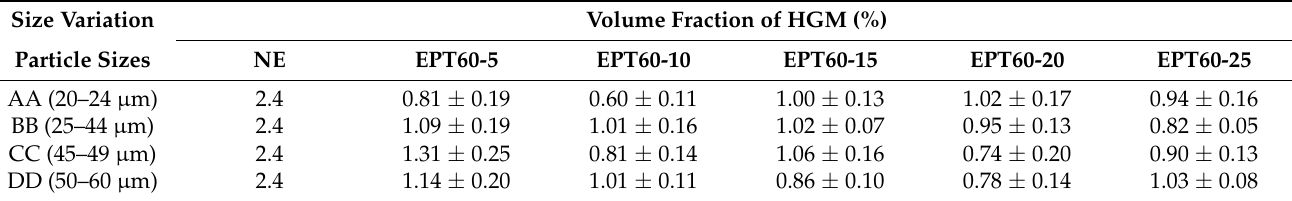
Figure 3. ( a – d ): Stress-strain graphs for SFCs compared to the neat epoxy (EPT60-0). Table 3. Flexural modulus of SFC filled with HGM-epoxy resin